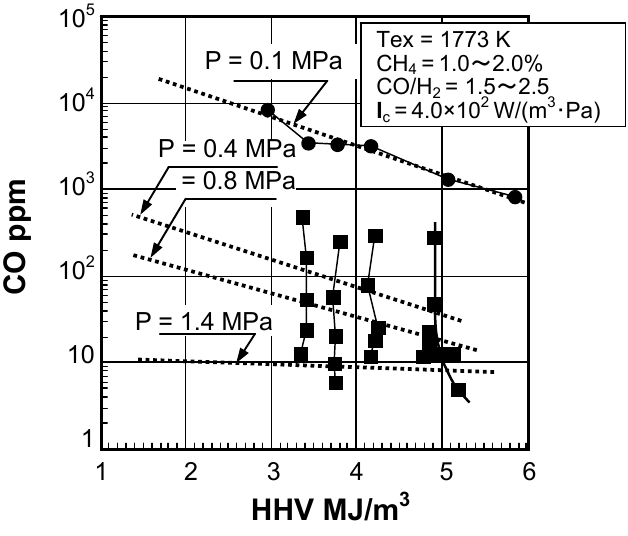
Figure 53. Influences of fuel calorific value and pressure inside combustor on CO emission characteristics. ● , ■ : Experimental data. Broken lines correspond to exponential approximations on a like-for-like basis of pressure. These lines are interpolated within the range of experimental data and drawn by extrapolation to lower fuel calorie